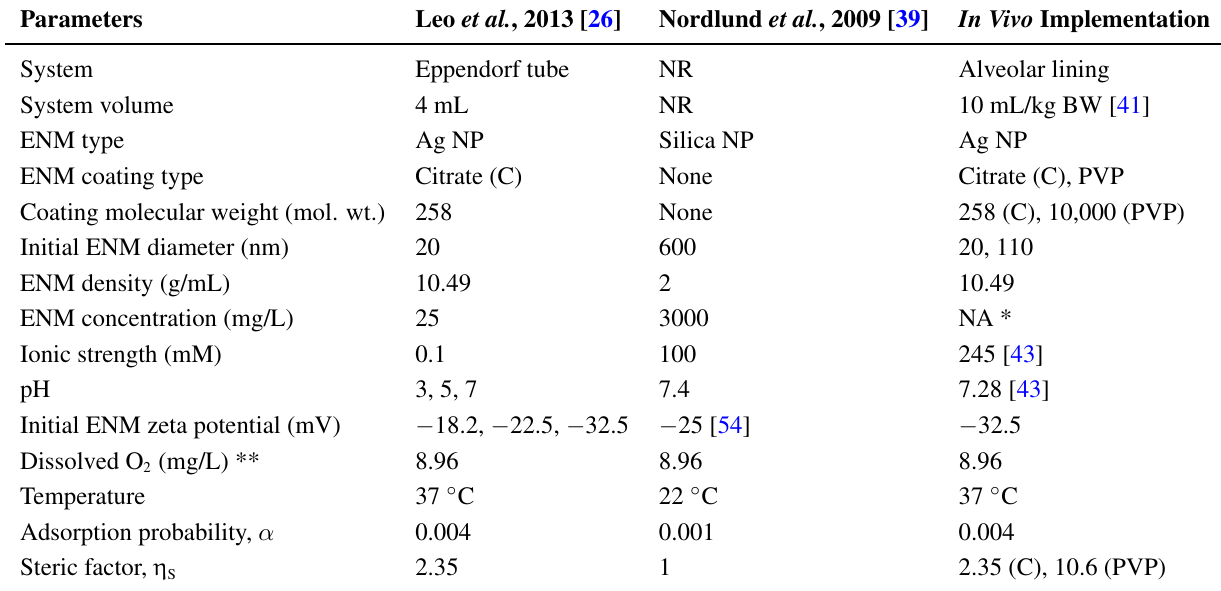
Table 4. Parameters used for model implementations.